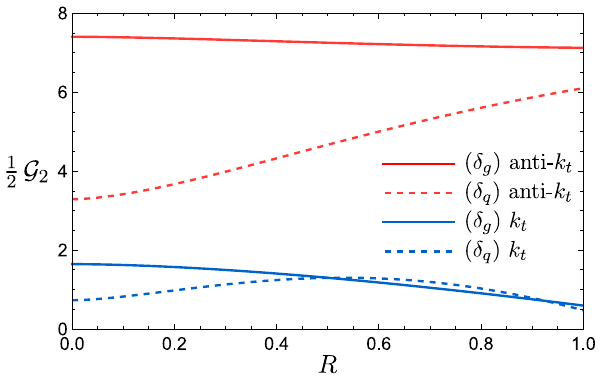
Figure 2 . Coefficient of NGLs at two loops for the two algorithms k t and anti- k t clustering, and for the two channels ( δ